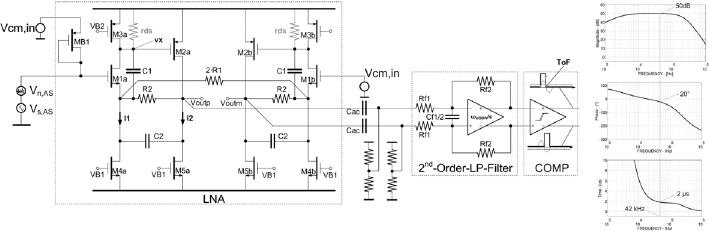
Figure 2. Left: AFE Schematic. Right: AFE magnitude, phase and group delay frequency responses .